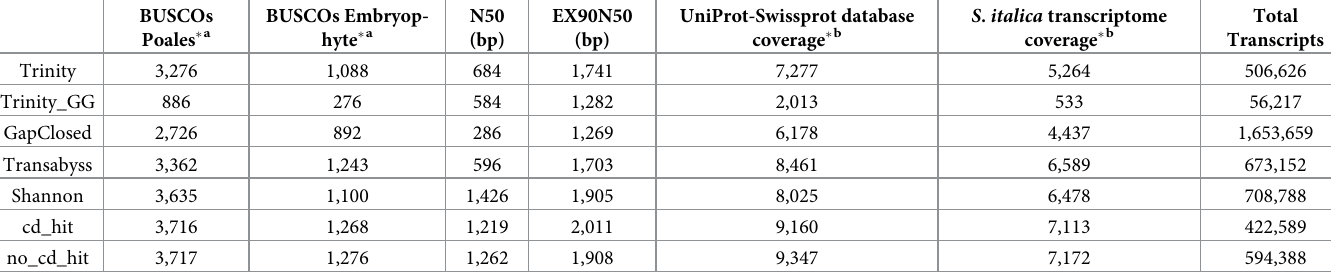
Table 2. Statistics of main transcriptome assembly assessments for seven constructed transcriptome assemblies. BUSCOs Poales �